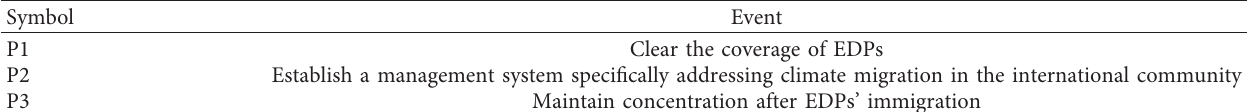
Table 3: Explanation of symbols.